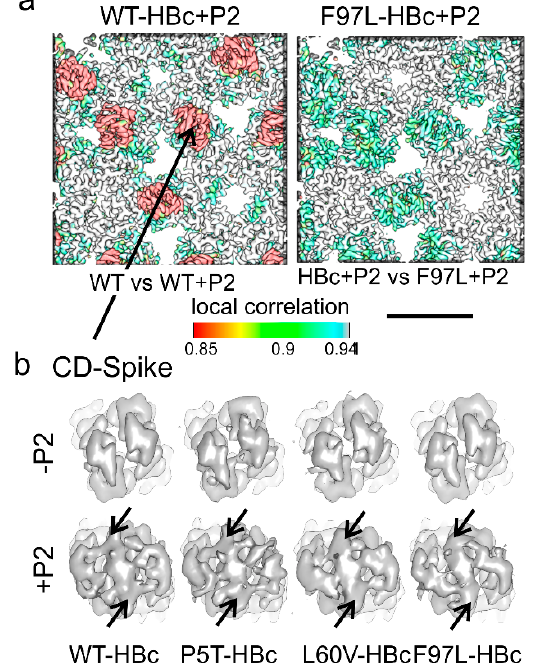
Figure 4. Capsid surface of HBc variants with bound peptide: ( a ) Two exemplary representations of the capsid surface close to a local 3-fold symmetry axis are shown for WT-HBc with bound P2 on the left and for F97L-HBc with bound P2 on the right. WT-HBc binds P2 strongest and F97L-HBc weakest. For WT-HBc, the surface is colored by the local correlation between WT-HBc-maps with and without bound P2. The local correlation is low in the upper half of the spikes (red), highlighting differences between the maps attributed to peptide binding and the induced conformational changes. For F97L-HBc, the surface is colored by the local correlation between F97L-HBc + P2 and WT-HBc + P2. The local correlation is high at all places suggesting that the HBc variants adapt similarly to P2 binding. The color key for the local correlation is given below and is the same as in Figure 3. The scale bar indicates 5 nm. A table with all maps colored by local correlation is shown in Figure S4. ( b ) Close-up of the tip of the CD spike without bound peptide (upper row) and with bound P2 bottom row. The map of F97L-HBc is taken from the EMDB entry 4417 [34] and scaled in the radial intensity profile of the power spectrum to match the other maps. All other maps were determined in this study. The density attributed to P2 is marked at either end by arrows. Broadening of the spikes with bound P2 is apparent.